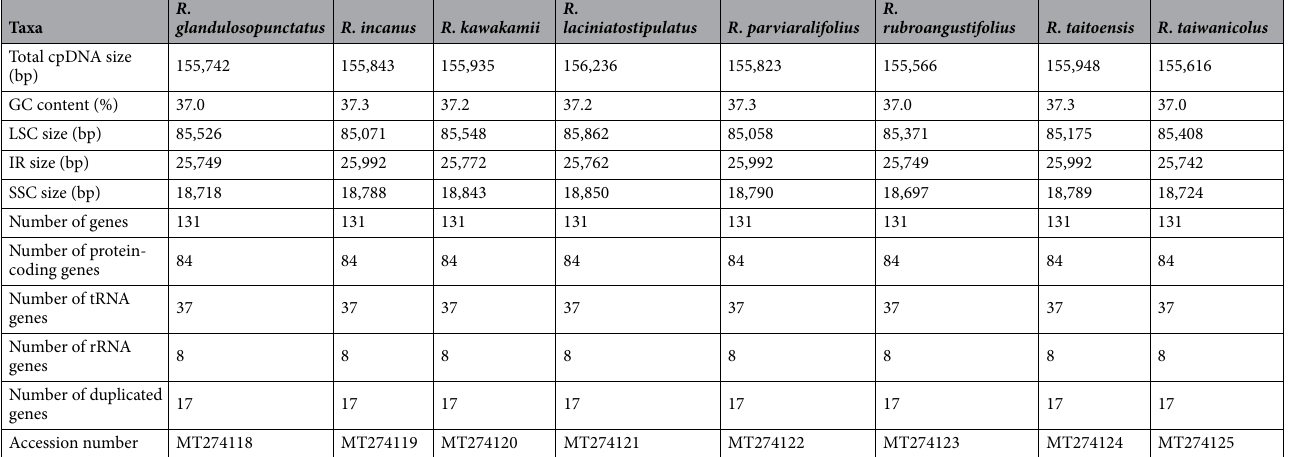
Table 1. Summary of the characteristics of the eight endemic Rubus chloroplast genomes in Taiwan. LSC large single copy region, IR inverted repeat, SSC small single copy region.